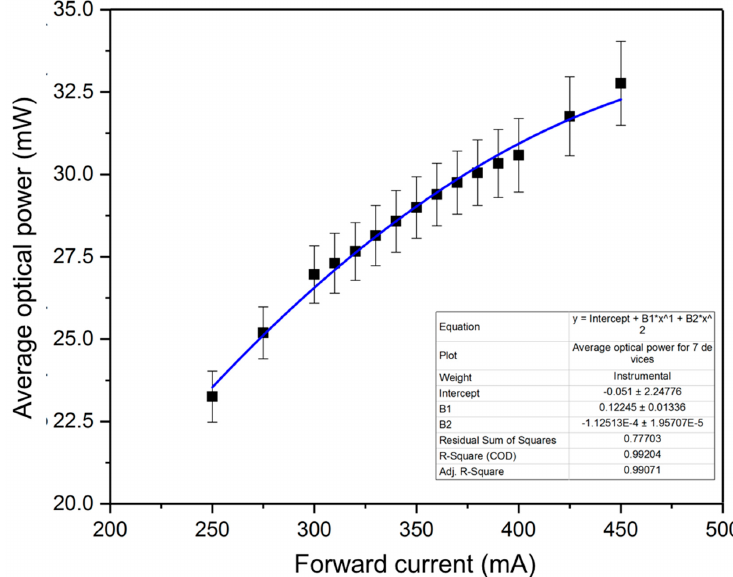
Figure 11. Measured average optical power for seven custom GaN LED devices versus forward bias current.